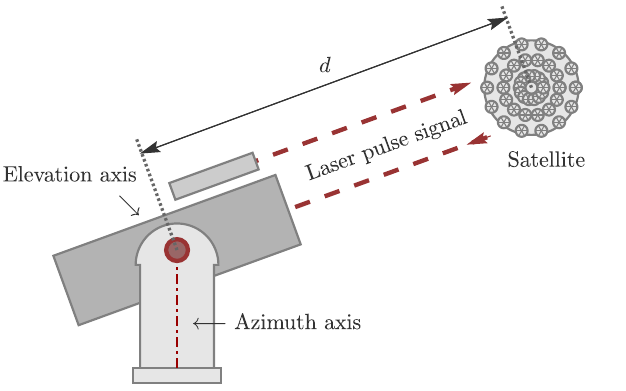
Figure 1. Schematic representation of the satellite laser ranging (SLR) measurement principle. The ILRS reference point of an SLR telescope is defined as the intersection point of the telescope axes. If both axes do not intersect, the point onto the azimuth axis, which is closest to the elevation axis, is the reference point [12]. Such a defined point is independent of the telescope orientation and is often referred to as invariant reference point (IRP). If this IRP is known w.r.t. to a reference point of a further space geodetic technique, both techniques become combinable within the intertechnique